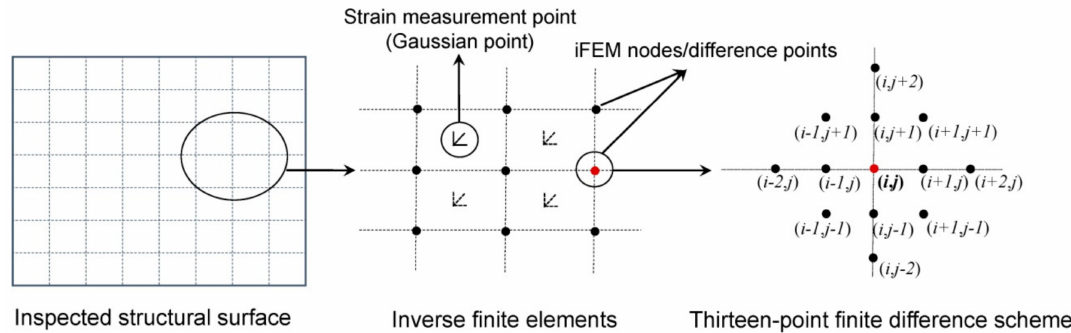
Figure 4. Point mapping and finite difference schemes for the iFEM-PE method.